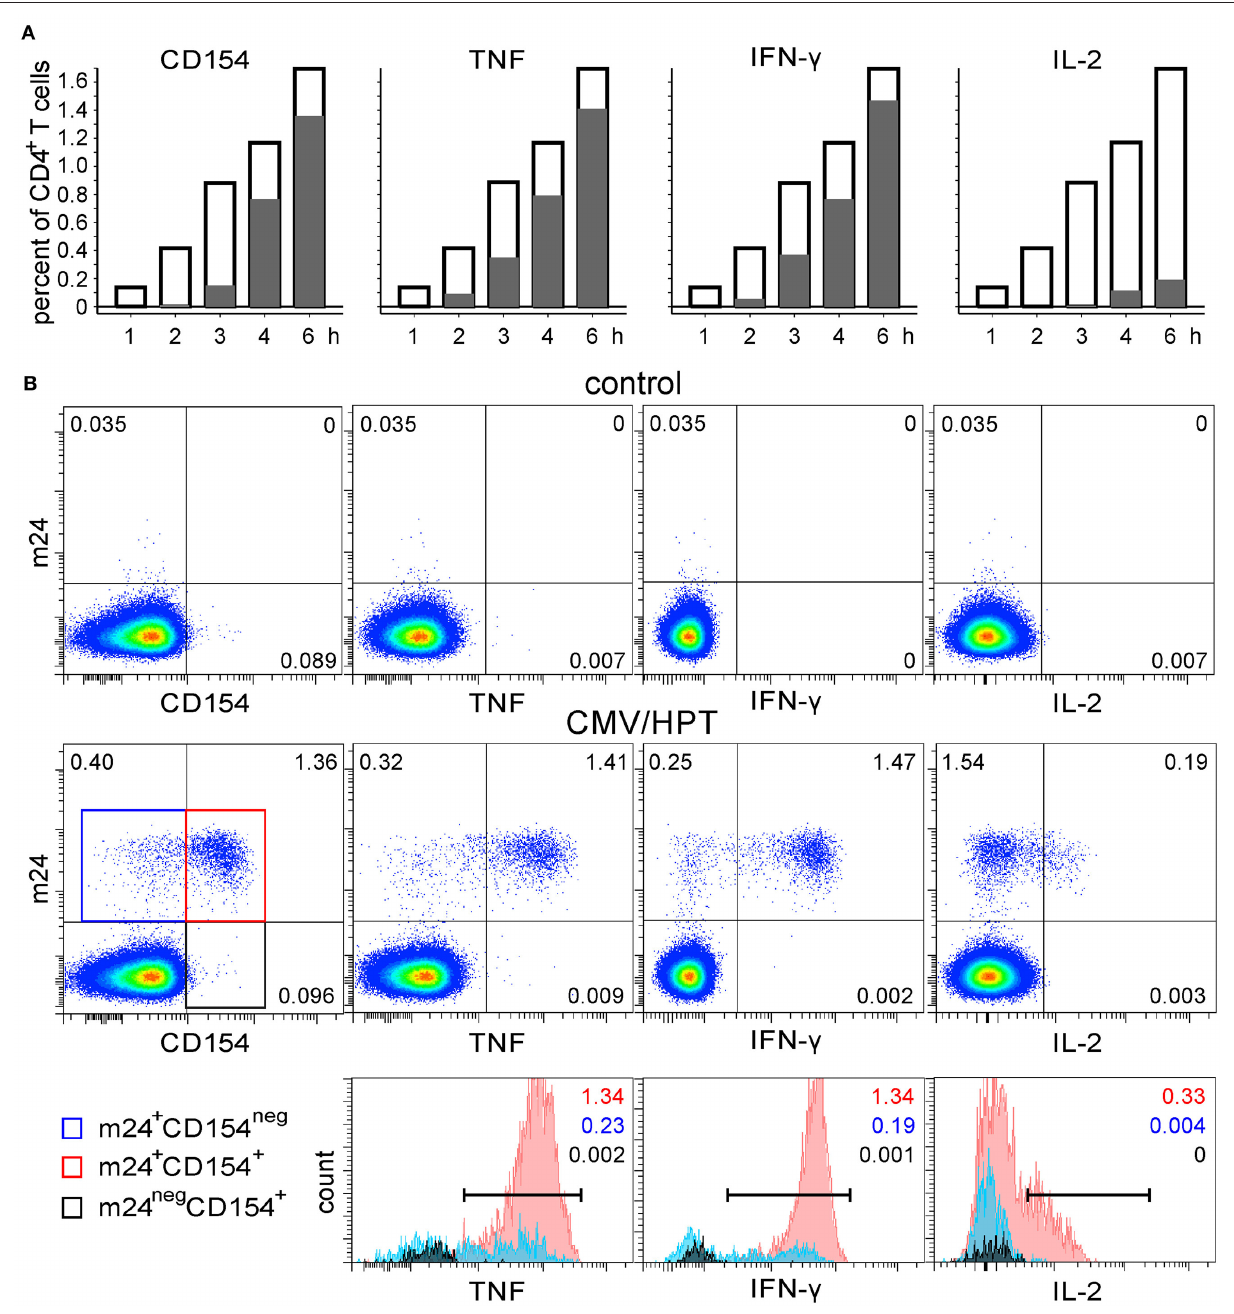
FIGURE 5 | The functional profile of CMV-specific m24 + CD4 + WB T cells. WB of a DRB1*11 + donor was stimulated with CMV/HPT peptide. (A) Frequencies of m24 Ab staining, CD154, and cytokine expression within CD4 + T cells are shown as bar graphs (at the indicated times and after subtraction of the background assessed in the control test); empty bars represent total m24 + cells, positive gray bars represent marker + (CD154, TNF, IFN- γ , or IL-2) m24 + CD4 + T cells, whereas negative gray bars (practically not visible) are marker + m24 neg CD4 + T cells. (B) Staining was obtained after 6h without stimulation (control, top) or in the presence of CMV/HPT (middle). Numbers on density plots indicate frequencies among CD4 + T cells. m24 + CD154 neg , m24 + CD154 + , and m24 neg CD154 + subsets were gated (middle panel: blue, red, and black frames, respectively) and further displayed as histograms according to their TNF, IFN- γ , and IL-2 expression (bottom). Numbers on histograms indicate frequencies of the respective color-coded population among CD4 + T cells (markers are shown). Gating strategy is as shown in Figure 1A .